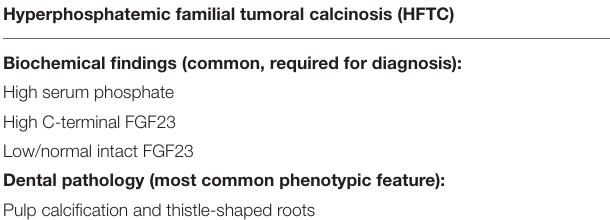
TABLE 1 | The diagnostic criteria of hyperphosphatemic familial tumoral calcinosis (HFTC). Hyperphosphatemic familial tumoral calcinosis (HFTC) Biochemical findings (common, required for diagnosis): High serum